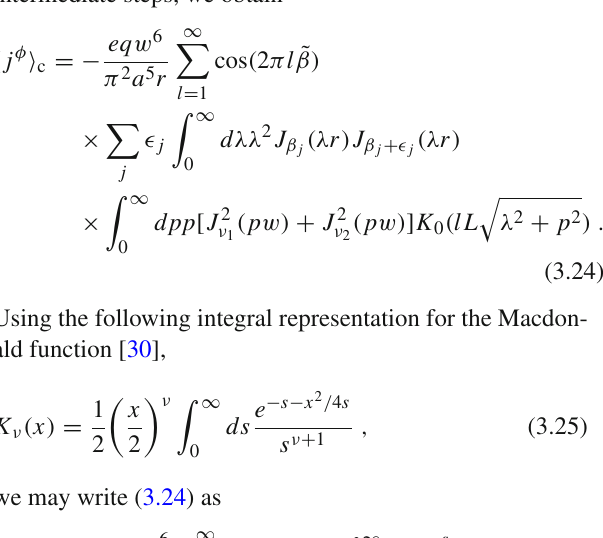
Fig. 3 The azimuthal current induced by compactification given in (3.28) is plotted in units of a 5 e − 1 as function of ˜ β and α 0 for fixed r /w = 1, ma = 5 and q = 2 .